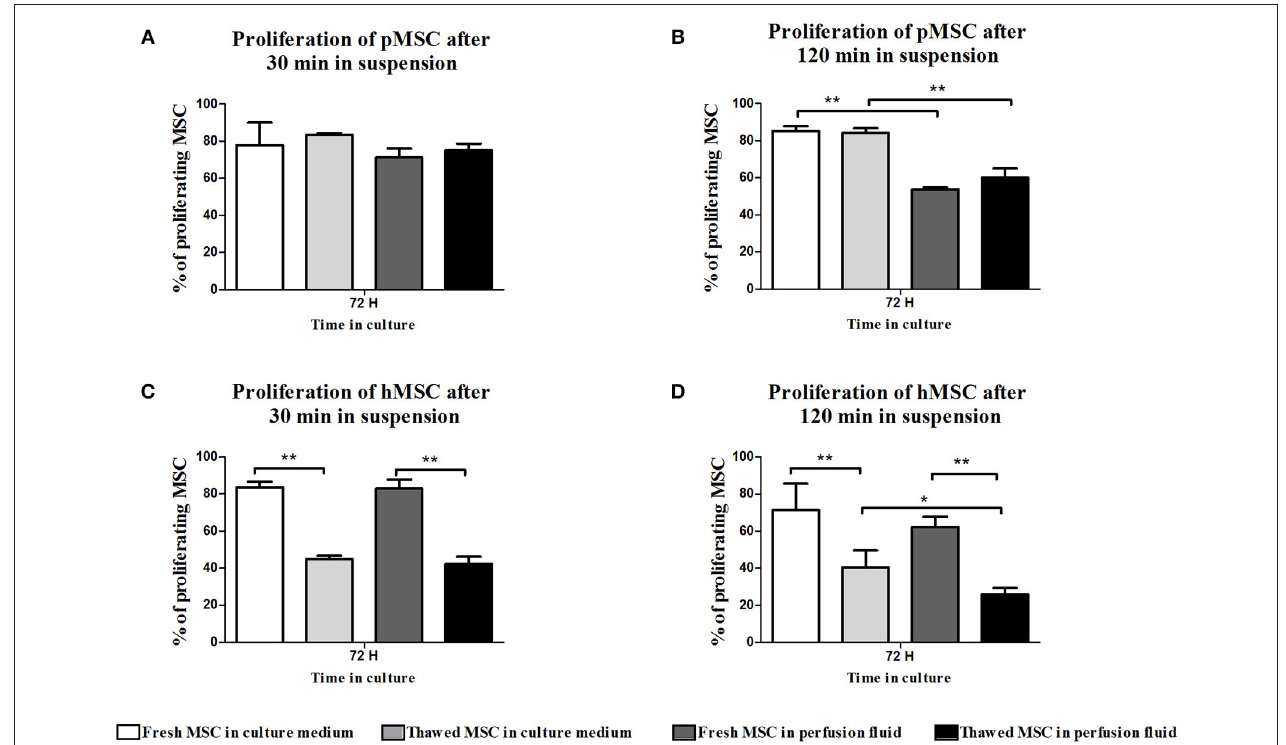
FIGURE 4 | Effect of perfusion fluid and freeze-thawing on proliferation of MSC. pMSC and hMSC were incubated in perfusion fluid for 30 and 120min and proliferation was measured after subsequent culturing in medium after 72h. (A) pMSC proliferation was not affected by incubation in perfusion fluid for 30min. (B)